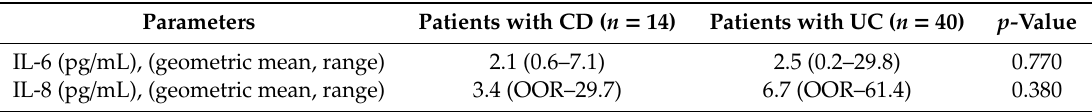
Table 2. IL-6 and IL-8 baseline values.